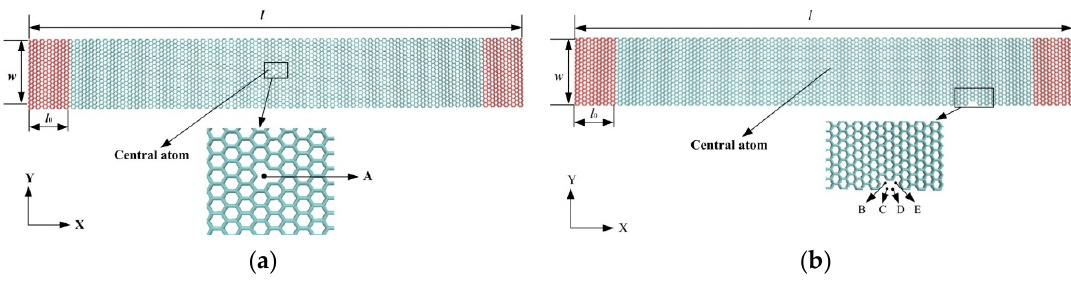
Figure 3. Simulation model of the graphene sheet with defects: ( a ) Single vacancy defect; ( b ) Edge defects.